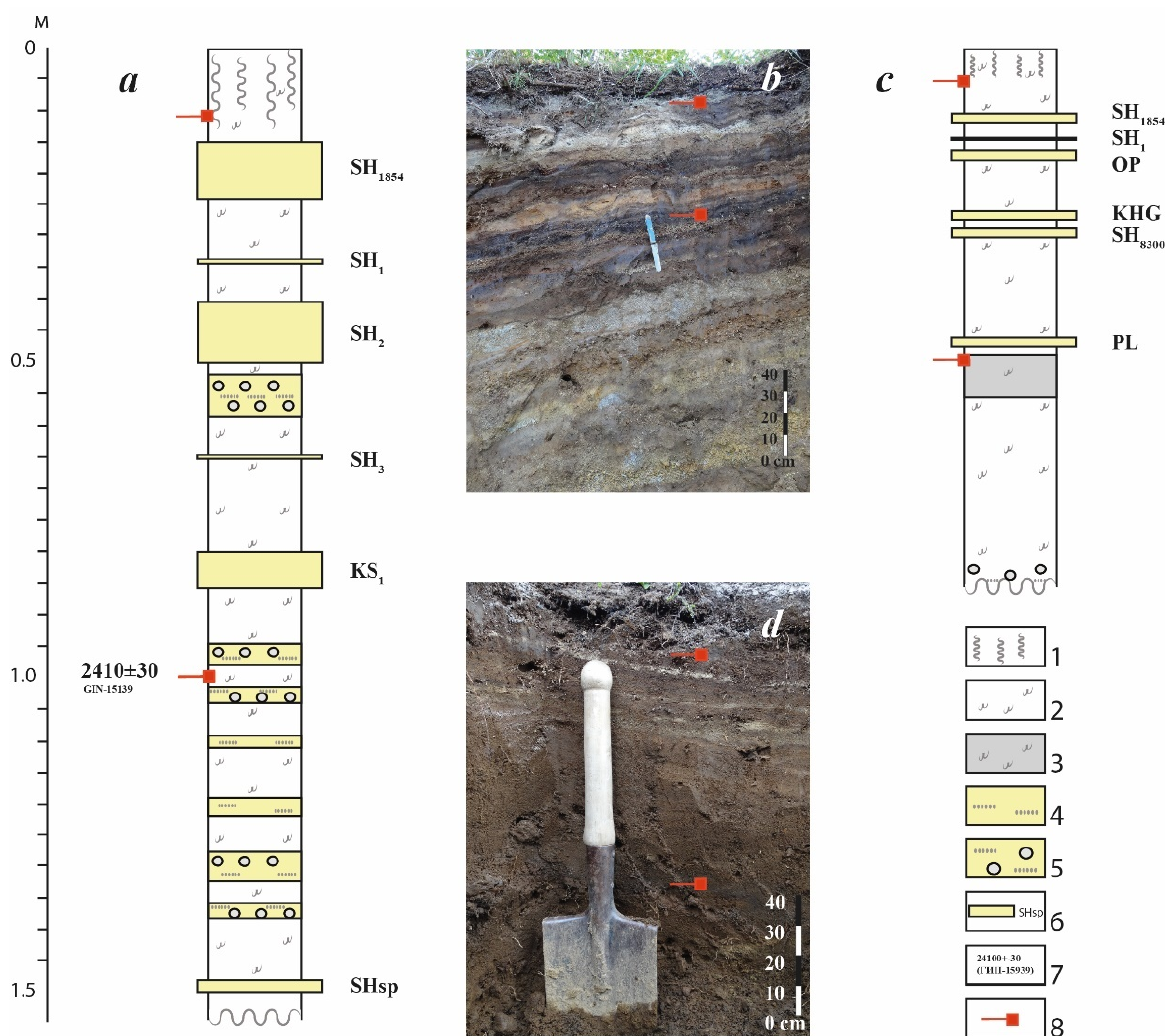
Figure 2. Structure of the studied soil profiles: ( a , b )—volcanic stratified ochre soil (Shiveluch), ( c , d )—volcanic humus-ochre soil (Tigil). 1—sod; 2—soil horizon; 3—highly humus buried soil horizon; 4–6—volcanic ashes: 4—volcanic sand, 5—gravel and lapilli of volcanic pumice, 6—marking indices of ash interlayers according to [13,15]; 7—radiocarbon age and laboratory sample number; 8—sampling sites. Ashes from volcanoes: Shiveluch (SH), Mutton Amphitheater on Opala Volcano (OP), Hangar (KHG), Xudach (KS), Ploskaya (PL). Photo by M.M. Pevzner ( b ), T.D. Karimov ( d ).